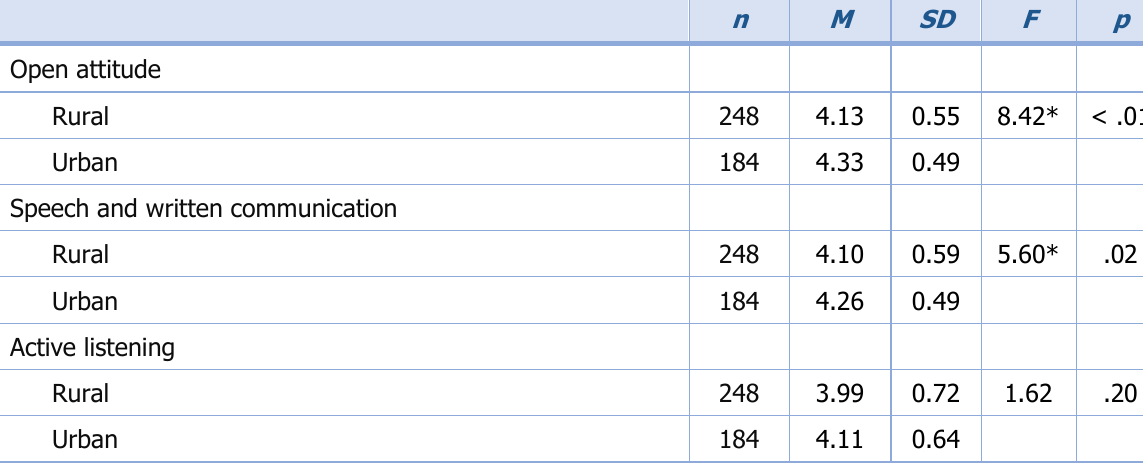
Table 7. Differences Between 4- H Extension Agents’ Percei ved Importance of the AEO Domain’s Communication Components and the Rural/Urban